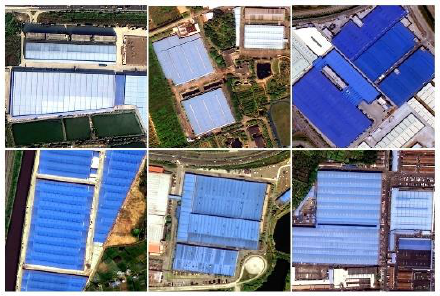
Figure 3. Blue steel roofs sample.